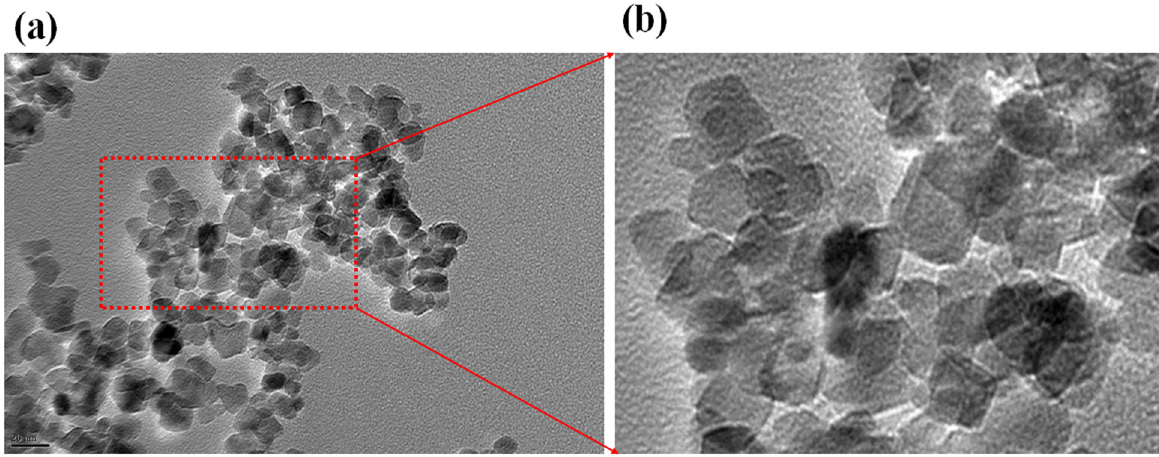
Figure 5. TEM analysis of PbO-doped NiO nanocomposite. ( a ) low-magnified image and ( b ) high- magnified image.